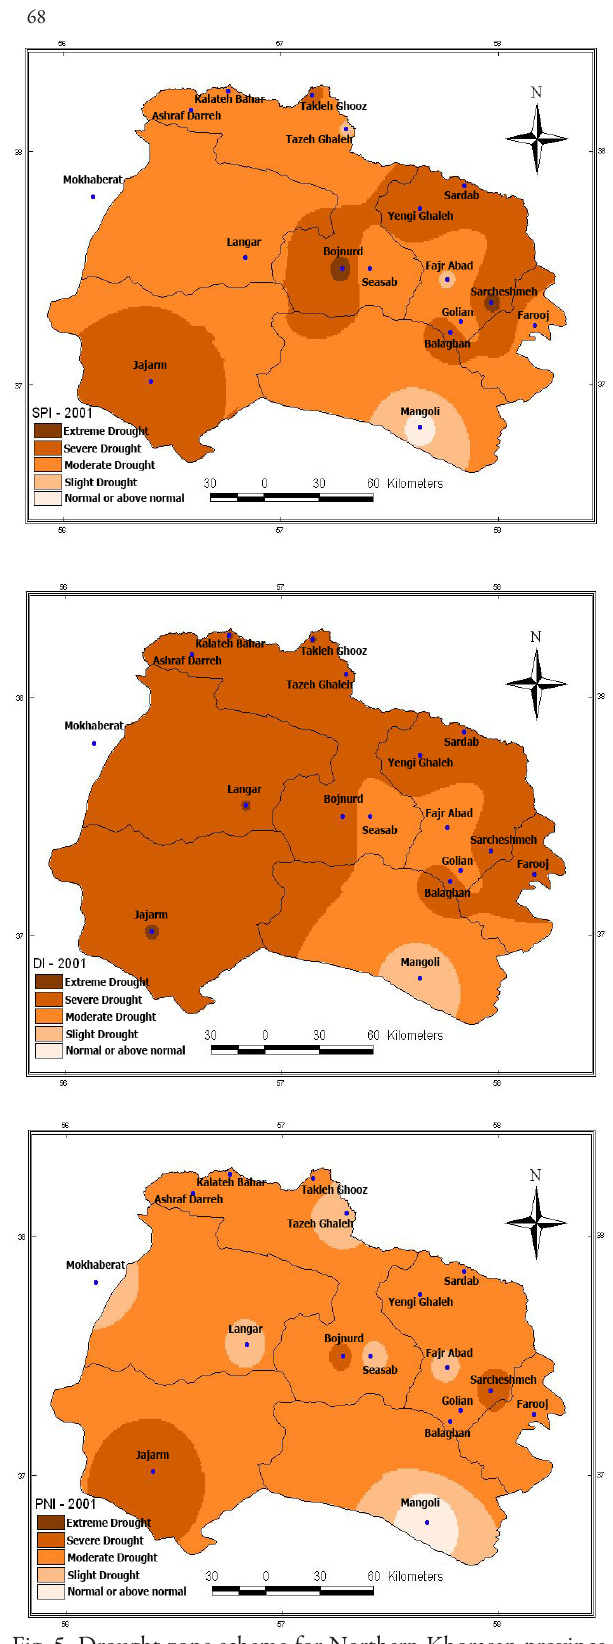
Fig. 5. Drought zone scheme for Northern Khorasan province by SPI ( Standard Rainfall Index) , DI ( Decades Index) and PNI ( Percent of Normal) indices in